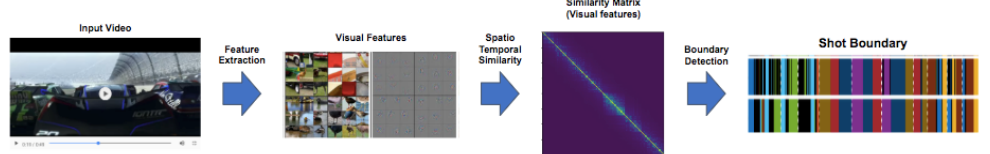
Figure 3. Overview of the framework for Shot Detection. Shot is defined as a group of continuous frames without a cut. To predict shot boundaries, the framework utilises only frame-level visual features from the given input